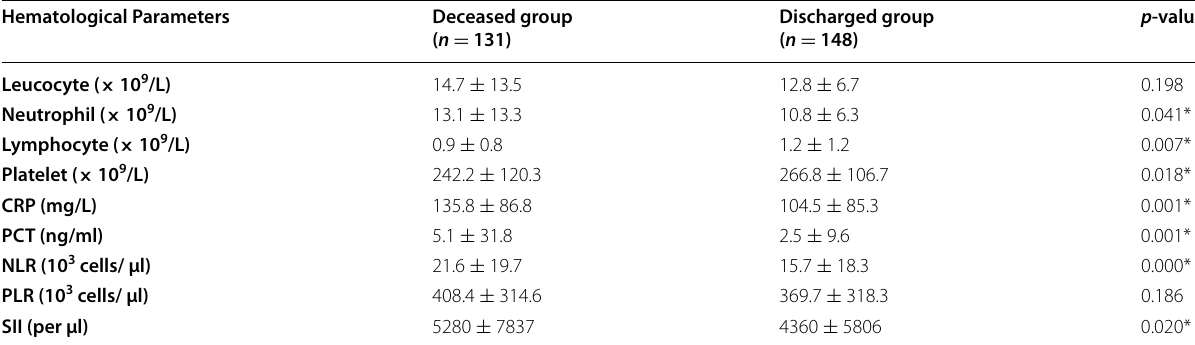
Table 2 Laboratory tests of 279 ICU patients with COVID-19